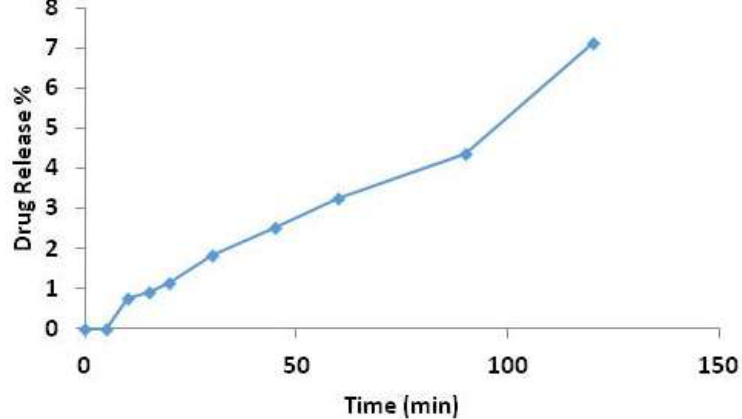
Figure 10. Drug release data for microfluidic prepared niosomes with Cremophor® ELP as a co-